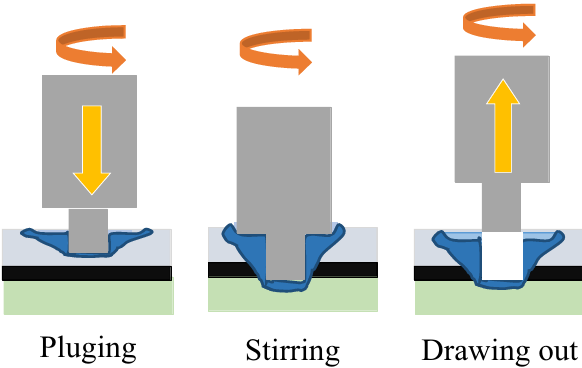
Figure 1: Illustration of FSSW process.